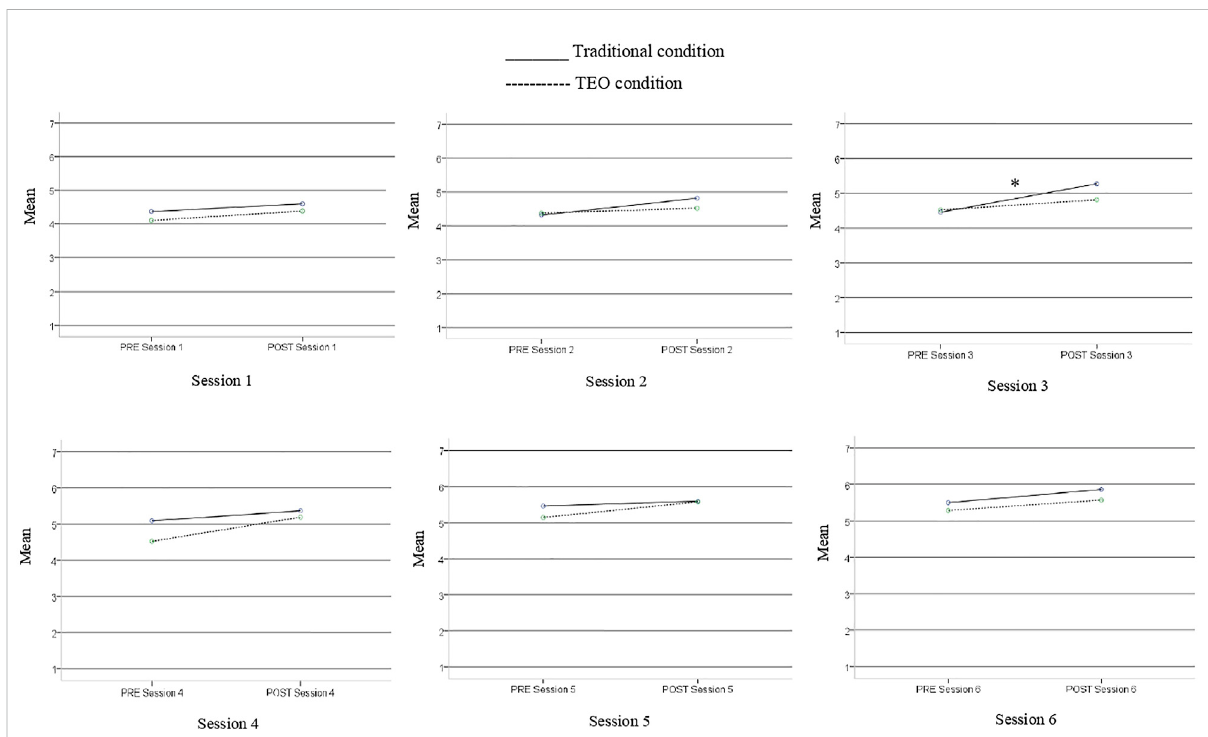
FIGURE 1 Mood means for both conditions assessed before and after each homework assignment session.* Signi fi cant change compared to the fi rst session.